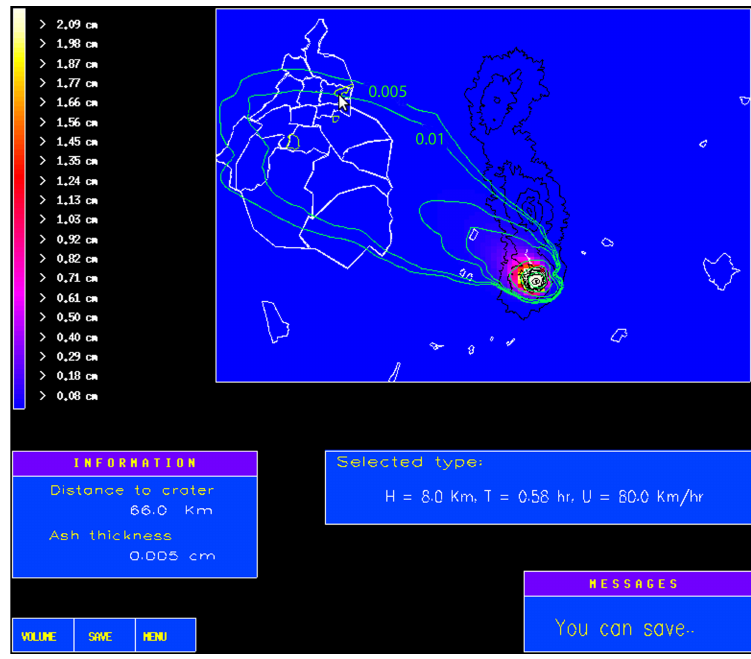
Fig. 11. SECCVO ashfall scenario of the 30 June 1997 Popocat´epetl eruption. The eruptive parameters were: column height H =8km, eruption duration τ =0.58h (32min), wind velocity U =80km/h (blowing towards Mexico city: ∼ 312 ◦ NW). The Information Window displays 0.005cm ash-thickness at the International Airport of M´exico City (where the cursor is) at 66.00km from volcano. The isopachs (in green) are from Martin Del Pozzo et al. (2008). The AICM is located between the first and two outermost isopachs (0.005 and